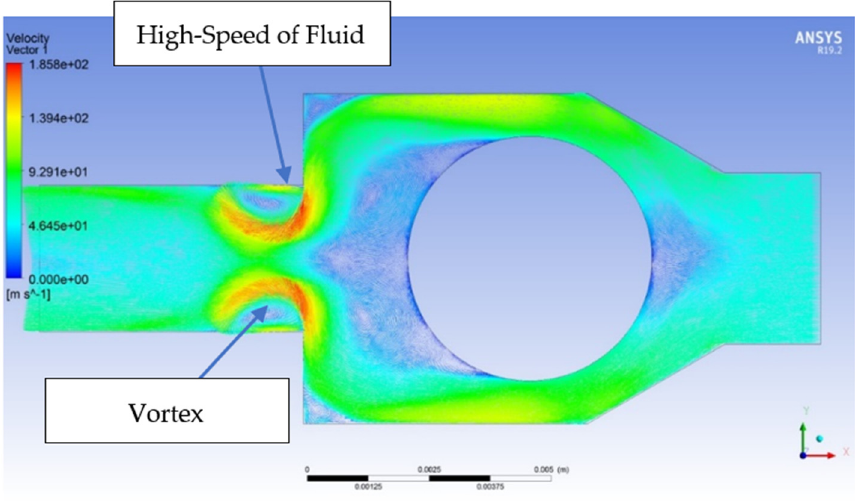
Figure 17. Velocity CFD: Conical Seat Valve: x = 1.257 [mm], pdn = 2000 [bar] and pup = 2100 [bar].